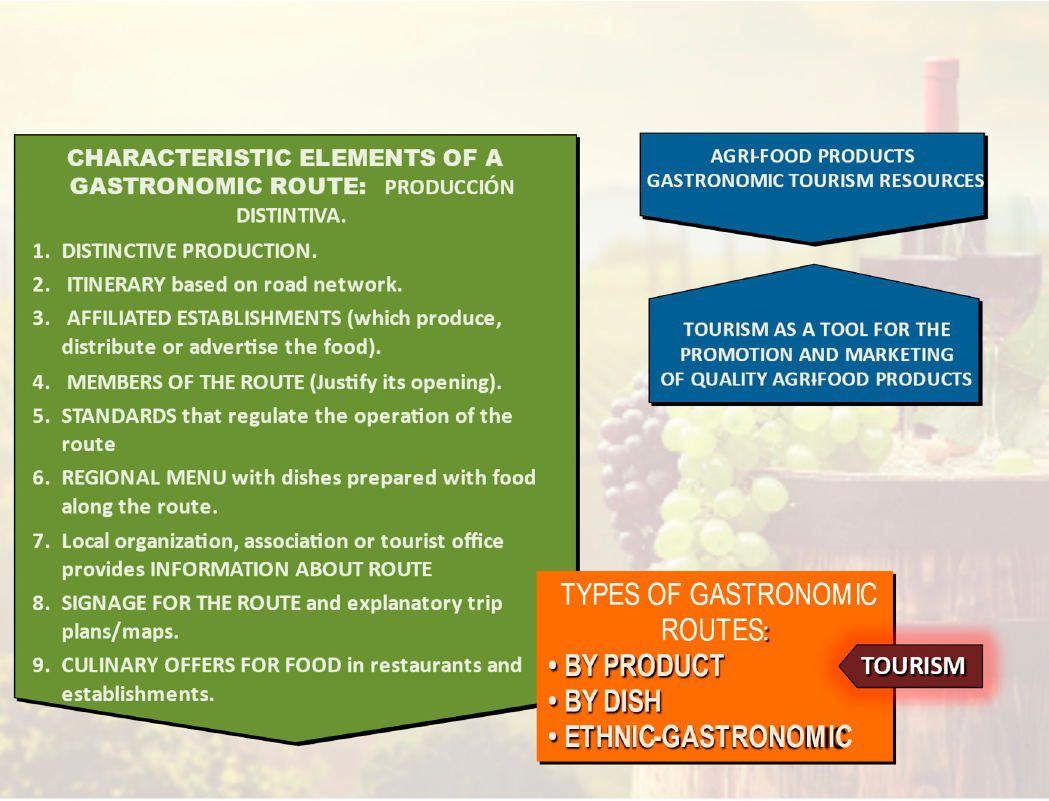
Figure 1. Elements of a gastronomic route. Source: Own elaboration.